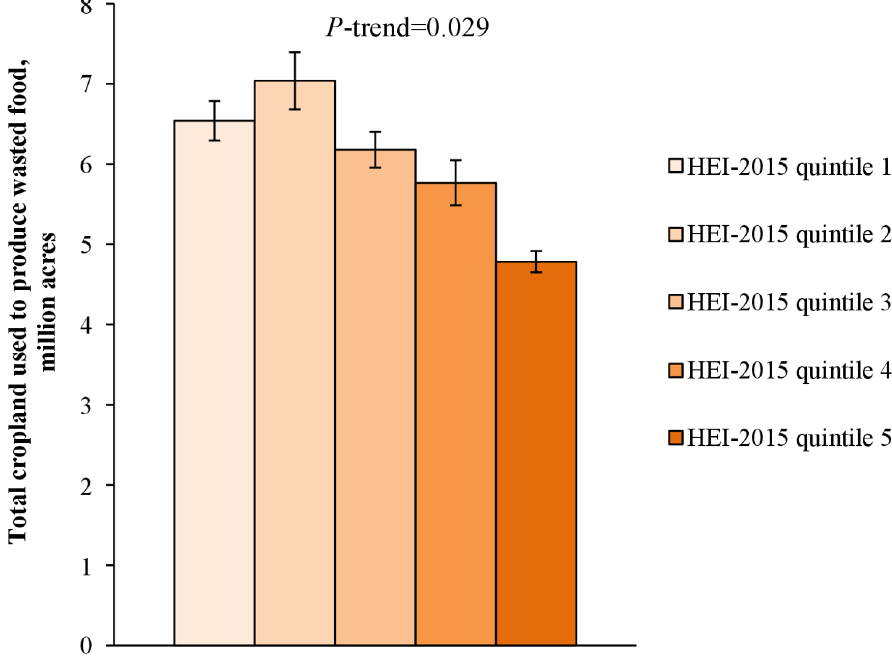
Fig 4. Total cropland used to produce wasted food, by diet quality. HEI-2015, Healthy Eating